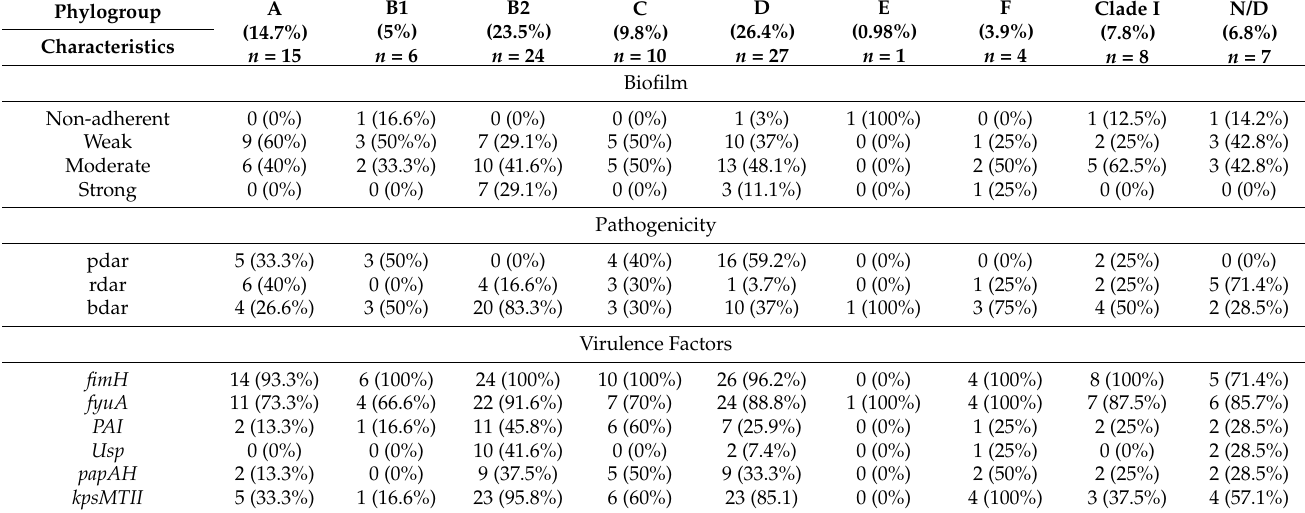
Table 1. Prevalence of virulence factors in various phylogenetic groups of isolated